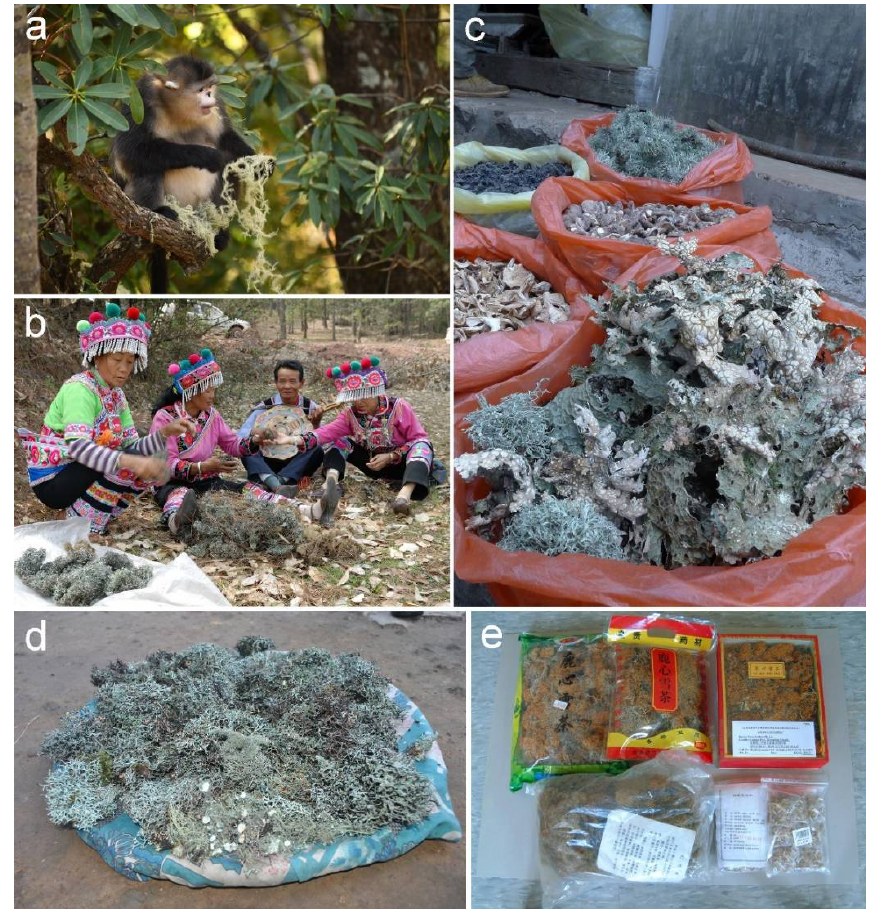
Figure 1. Lichens are used by animals and humans. ( a ) Rhinopithecus roxellana eating Usnea in southwestern China; ( b ) Bai minority people harvesting lichens in Yunnan; ( c ) Ethnic lichen market in Yunnan. ( d ) Freshly gathered lichens for the kitchen in Nepal; ( e ) Health-promoting tea products of Lethariella and Thamnolia ; ( a – c , e ) photographed by Li-Song Wang; ( d ) photographed by Shiva Devkota.